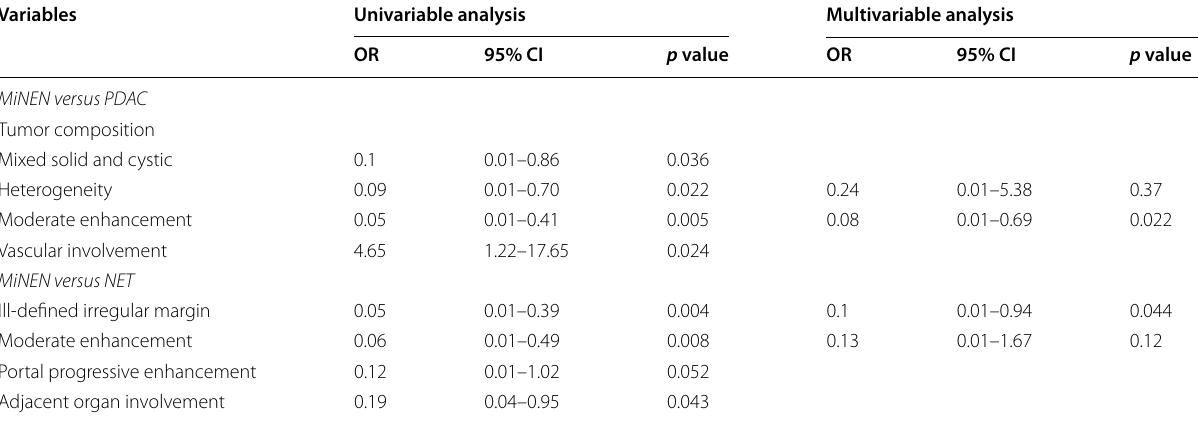
Table 3 Results of univariate and multivariate conditional logistic regression analyses for differentiating pancreatic MiNEN from PDAC or